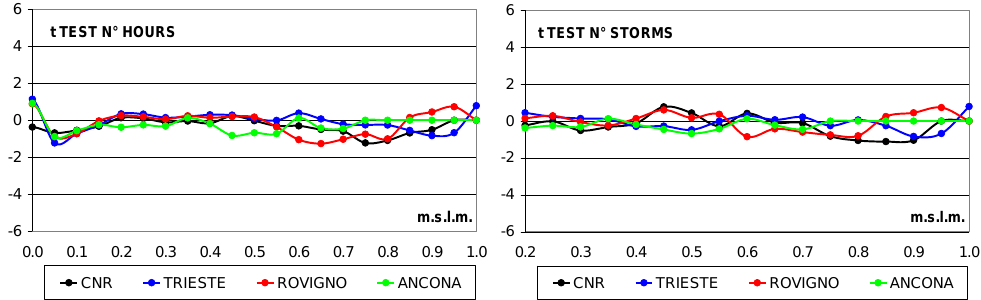
Figure 8. Cumulated distribution of the number of hours (left panel, the enlarged scale on the right is used for sea levels above 0.50m) and number of storms (right panel) above fixed sea level thresholds in present and future climate conditions at the ISMAR-CNR platform.